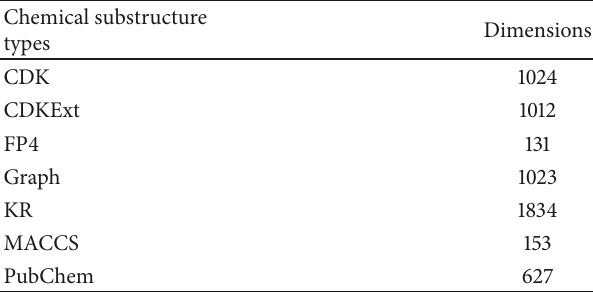
Table 2: The dimensions on